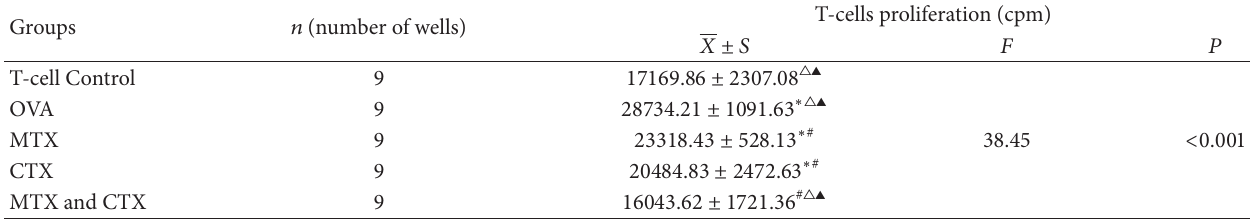
Table 7: Stimulation index of mixed lymphocytes stimulated by BMDC on 9th